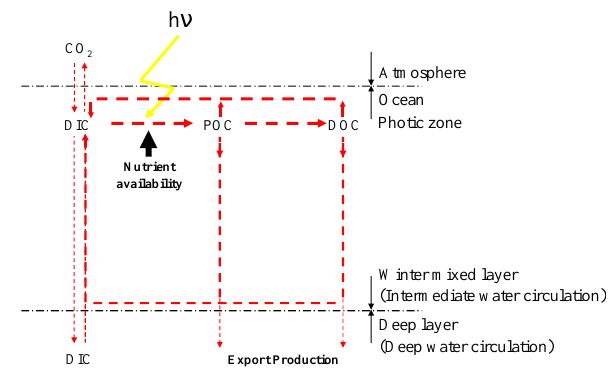
Fig. 1. Major carbon fluxes for a biological pump budget. Biolog- ical pump: carbon transfer by biological processes into the ocean interior. DIC: dissolved inorganic carbon, POC: particulate organic carbon, DOC: dissolved inorganic carbon. Modified from Moutin et al.